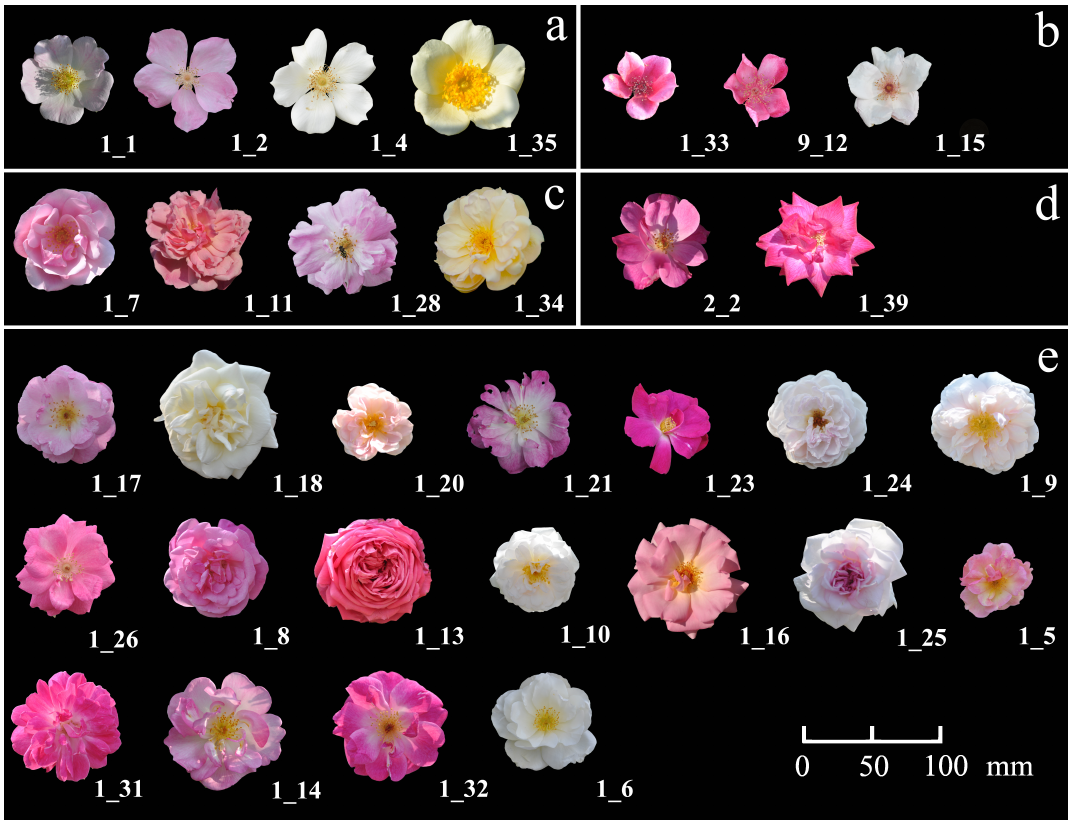
Figure 1. Variation of rose accession flowers: ( a ) R. odorata var. gigantea ( b ) R. chinensis var. spontanea ( c ) R. odorata var. odorata ( d ) R. chinensis var. chinensis ( e ) R. sect. Chinenses complex. While ( a , b ) are wild type rose accessions, ( c – e ) are the cultivated types of rose accessions.